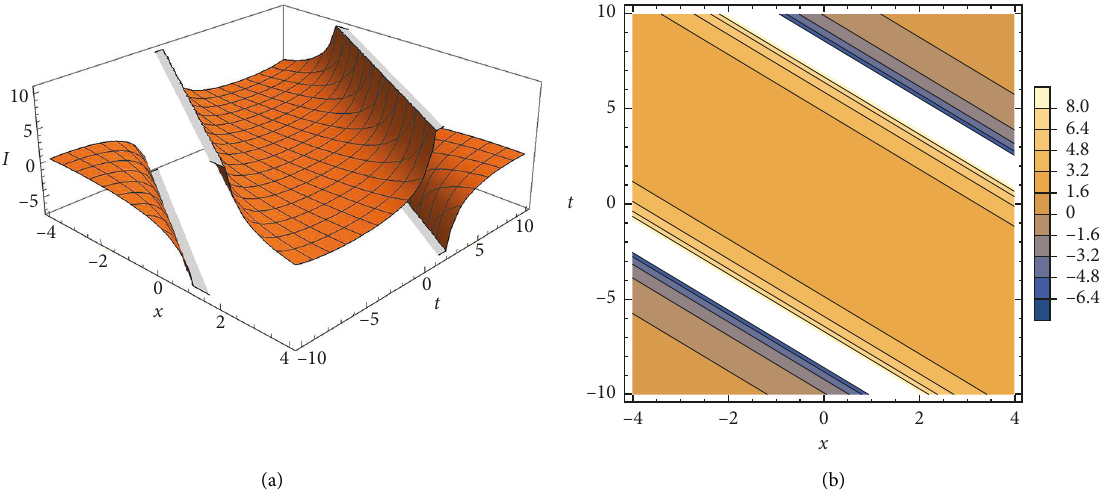
Figure 11: Graphic representation for the singular wave solution (37). (a) 3D graphic and (b) 2D